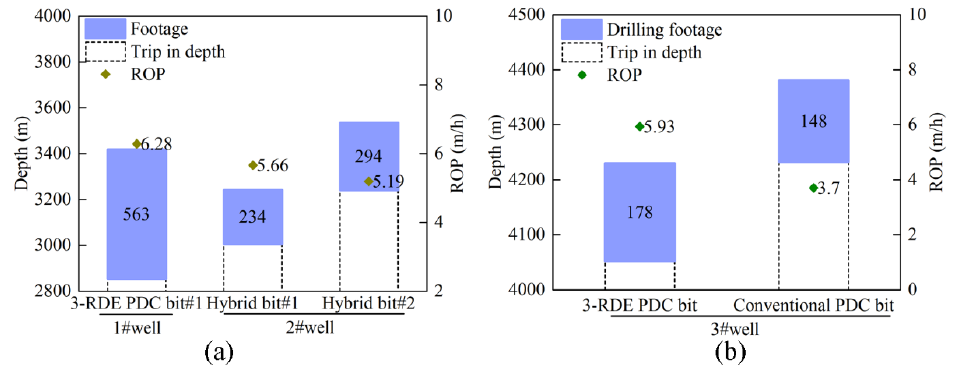
Figure 20. Application of ( a ) 3-RDE PDC bit and Hybrid bit in gravel formation; ( b ) 3-RDE PDC bit and Hybrid bit in migmatitic granite formation.